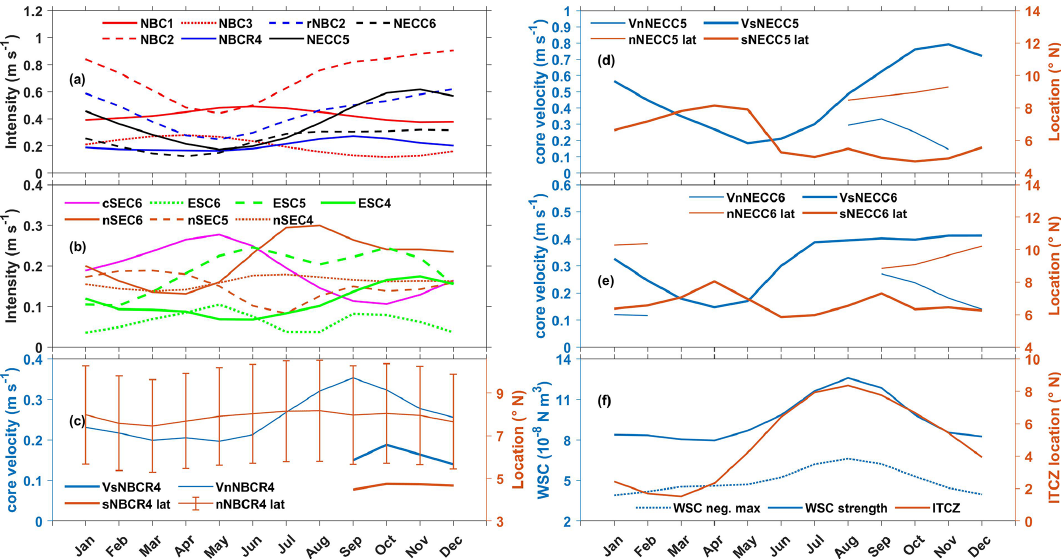
Figure 5. Monthly climatology of the relative current speed (ms − 1 ) (a–b) ; core velocities and locations in the NBCR regions (c) ; the core velocities and locations of the NECC branches along HS5 and HS6 (d–e) ; and the absolute values of the maximum negative wind stress curl (WSC neg. max), WSC strength, and ITCZ location (f) . Acronyms are listed in Table 1, and the numbers next to the acronyms represent the numbers of the horizontal sections. In (c) , (d) , and (e) , the core velocities and locations are shown in blue and orange,